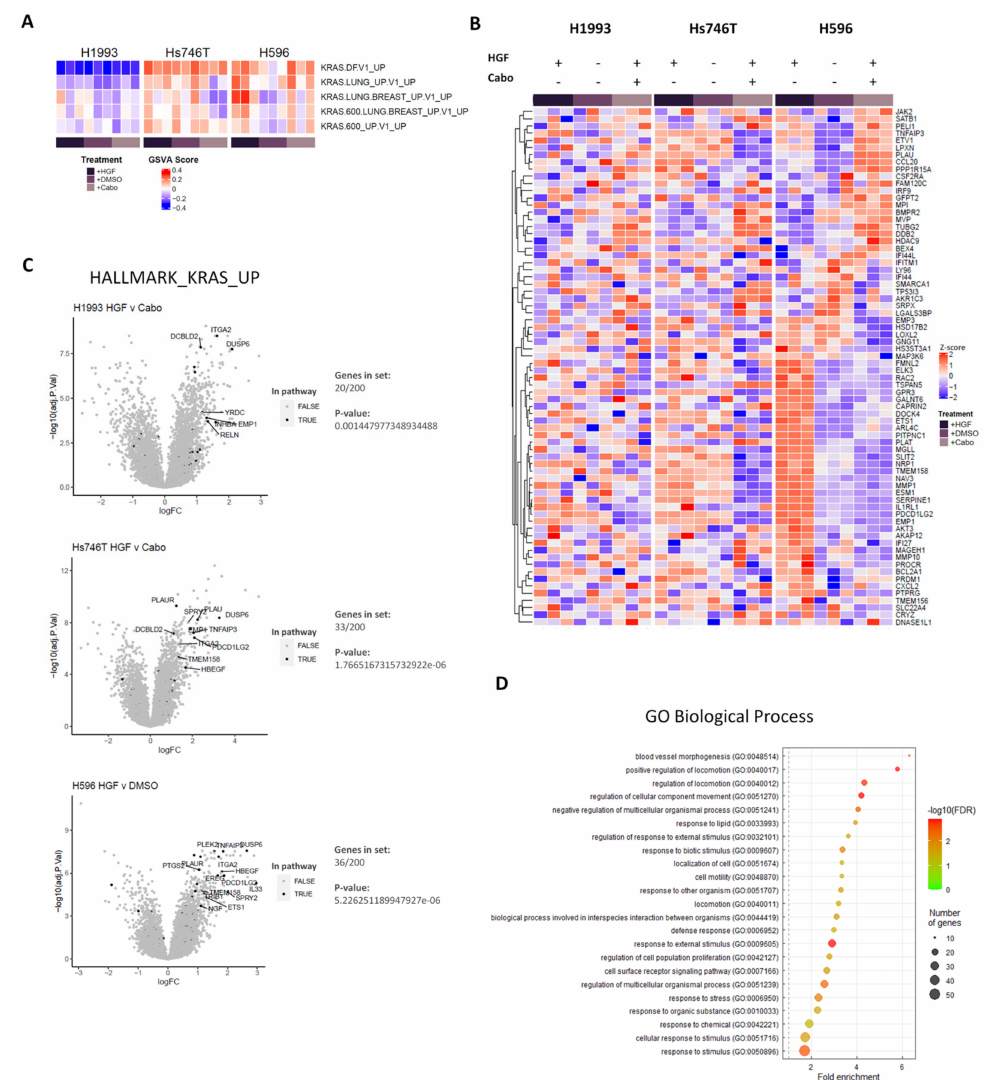
Figure 2. KRAS activation signature observed in exon14-skipping mutants is dependent on MET receptor activity. ( A ) GSVA comparing relative enrichment of KRAS-associated gene sets to NES of all gene sets from the entire Oncogenic_signatures library. Heatmaps show positive enrichment of Ras- driven genetic signatures in MET ∆ ex14 -expressing cancer lines, in contrast to negative enrichment observed for the wild type MET -amp driven cell line. ( B ) Unsupervised clustering identifies a subset of genes within Ras-associated gene sets which correlate with MET receptor activity in MET ∆ ex14 -expressing cancer lines, but not in the H1993 cell line. ( C ) Volcano plots comparing relative changes in gene expression of H1993, Hs746T, and H596 cells between HGF stimulated or MET inhibited states. Significantly upregulated hits (log2[FC] > 0; Adj p -value < 0.05) that fell under the “HALLMARKS_KRAS_UP” gene set were tallied for each line, and the significance of their overrepresentation calculated using Fisher’s Exact Test. ( D ) Gene ontology analysis of leading edge genes shown in ( B , C ) heatmaps point to their functional involvement in angiogenesis, cell mobility, and